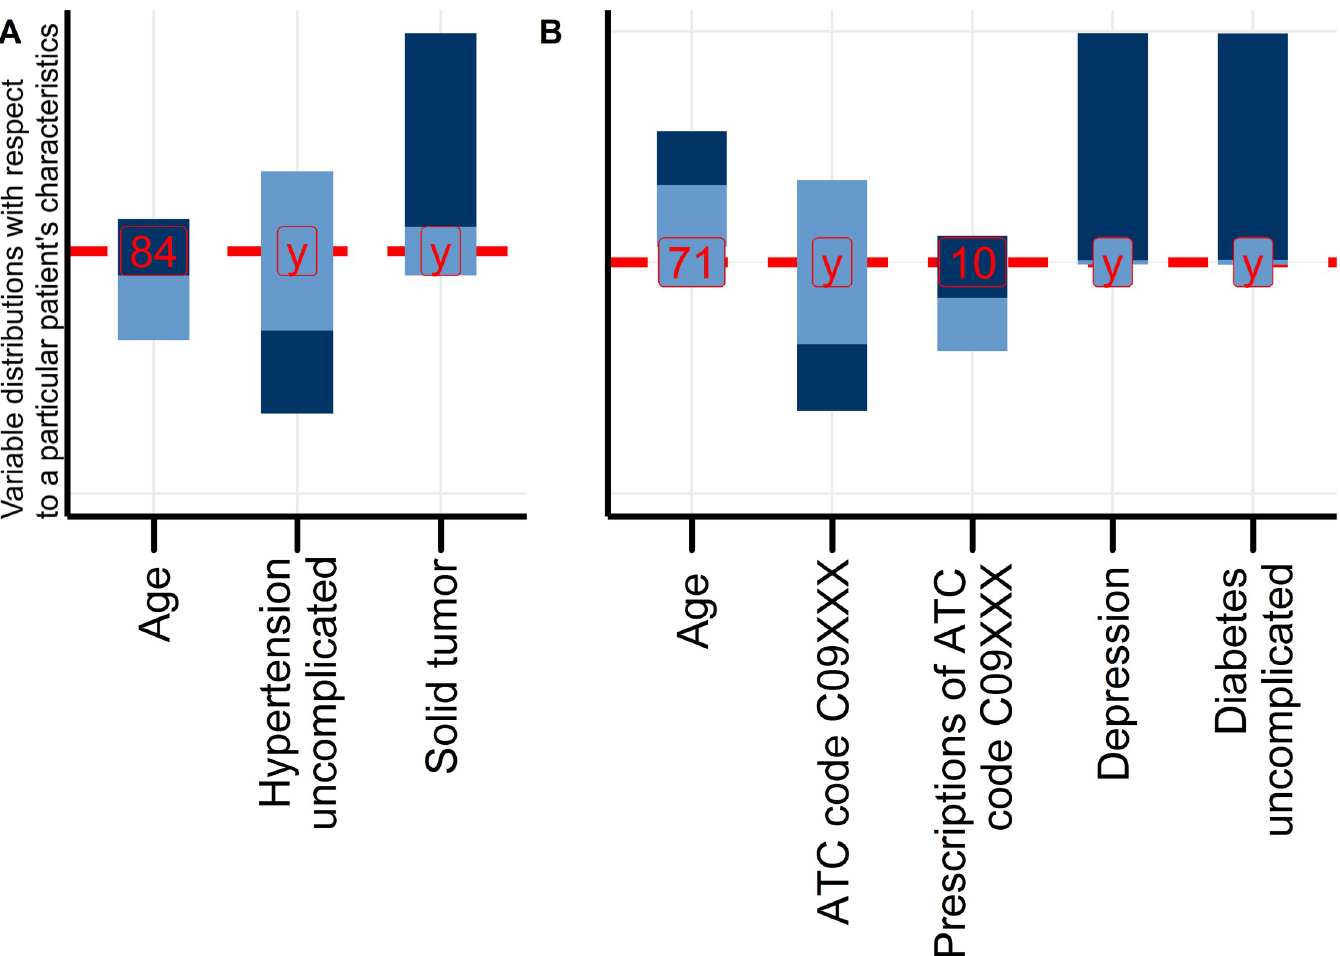
Fig 1. Scale charts of Patient 1 (A) and Patient 2 (B) in the initial, unselected cohort. The scale chart compares a patient’s characteristics (red vertical line) to the distribution of characteristics in the reference cohort (blue vertical bars). Each bar represents ranges derived from medians and interquartile ranges for continuous variables, and relative frequency for categorical variables. Different shades of blue indicate different categories or ranges above and below the median, respectively.